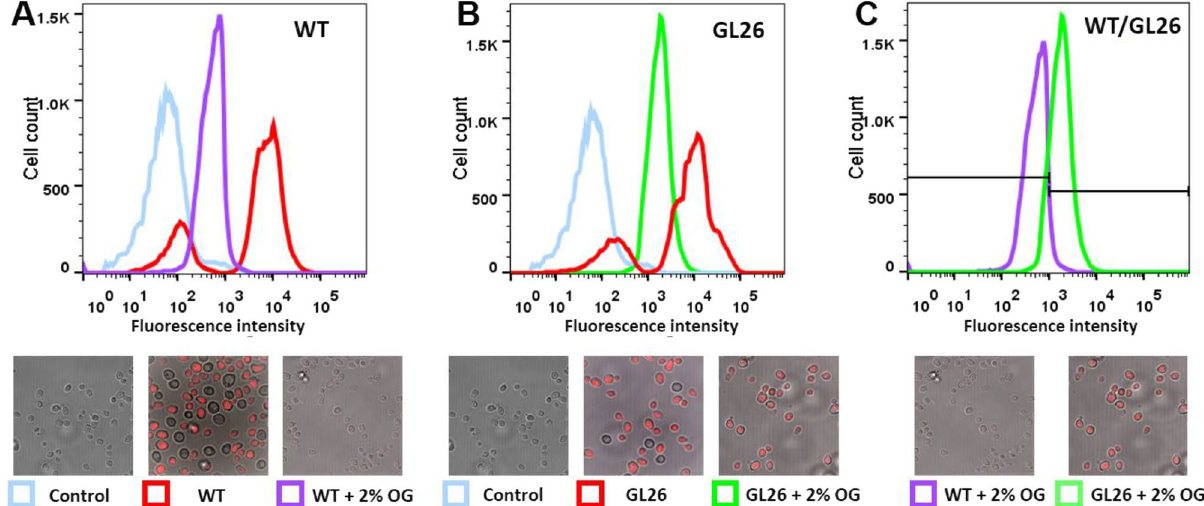
Figure 3. OG-resistant and unstable A2aR variants could be separated by flow cytometry of yeast. Permeabilized yeast expressing A2aR-WT ( A ) or thermostable GL26 mutant ( B ) were preincubated for 1 h with 20 nM CA200623, followed by 4 h incubation in the absence (red) or presence (purple or green) of 2% OG and CA200623, and after washing, analyzed by flow cytometry. Cells not expressing A2aR were used as control (light blue). ( C ) Fluorescence peaks corresponding to A2aR-WT ( A ) and GL26 ( B ) expressing cells treated with 2% OG are superimposed. Representative confocal microscope images of the samples analyzed by FACS are shown at the